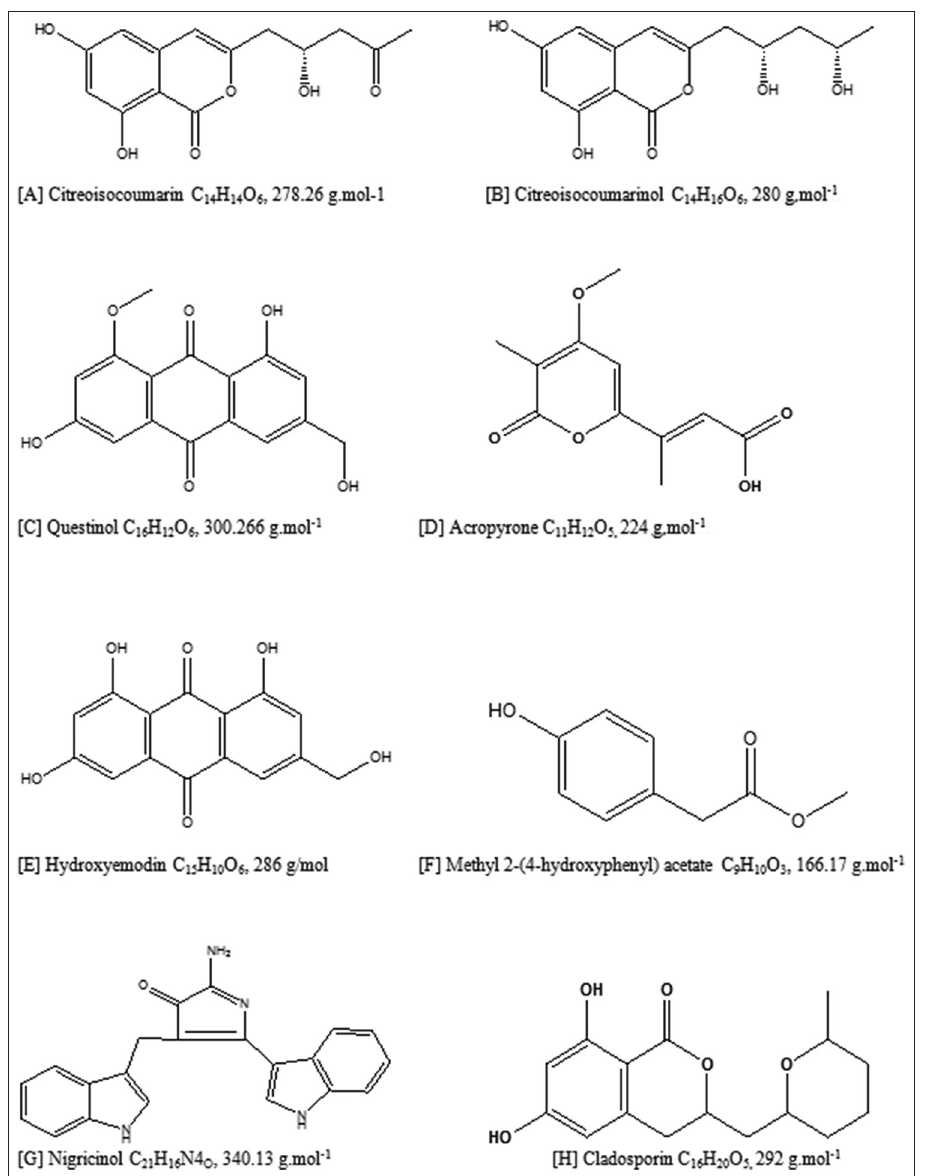
FIGURE 3. Chemical structures of detected compounds, (A) Citreoisocoumarin C C H O , 280 g.mol ‑1 , (C) Questinol C 14 16 6 286 g/mol, (F) Methyl 2‑(4‑hydroxyphenyl) acetate